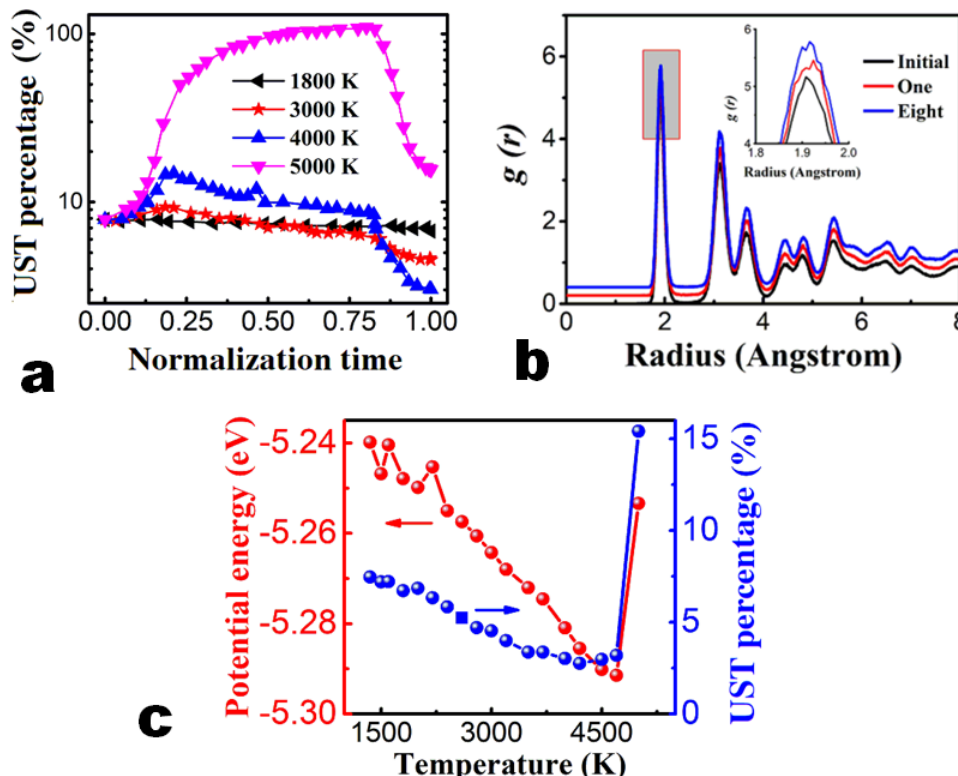
Figure 3. Change in film properties after constant temperature annealing. ( a ) Variation in the unidentified-structure-type (UST) atoms’ percentage during annealing at 1800 K, 3000 K, 4000 K, and 5000 K. ( b ) The radial distribution function (RDF, g ( r ) ) curves of the atomistic structures after annealing of different number of rounds at 4000 K. The initial (black line) structure, one-round-annealing (red line), and eight-round-annealing (blue line) structures are compared. The RDF curves are shifted 0.2 each for convenience of view. The inset is a zoom-in view of the first peak of RDF to conveniently show the difference. ( c ) UST atom percentage and average potential energy after annealing of different number of rounds at 4000 K.